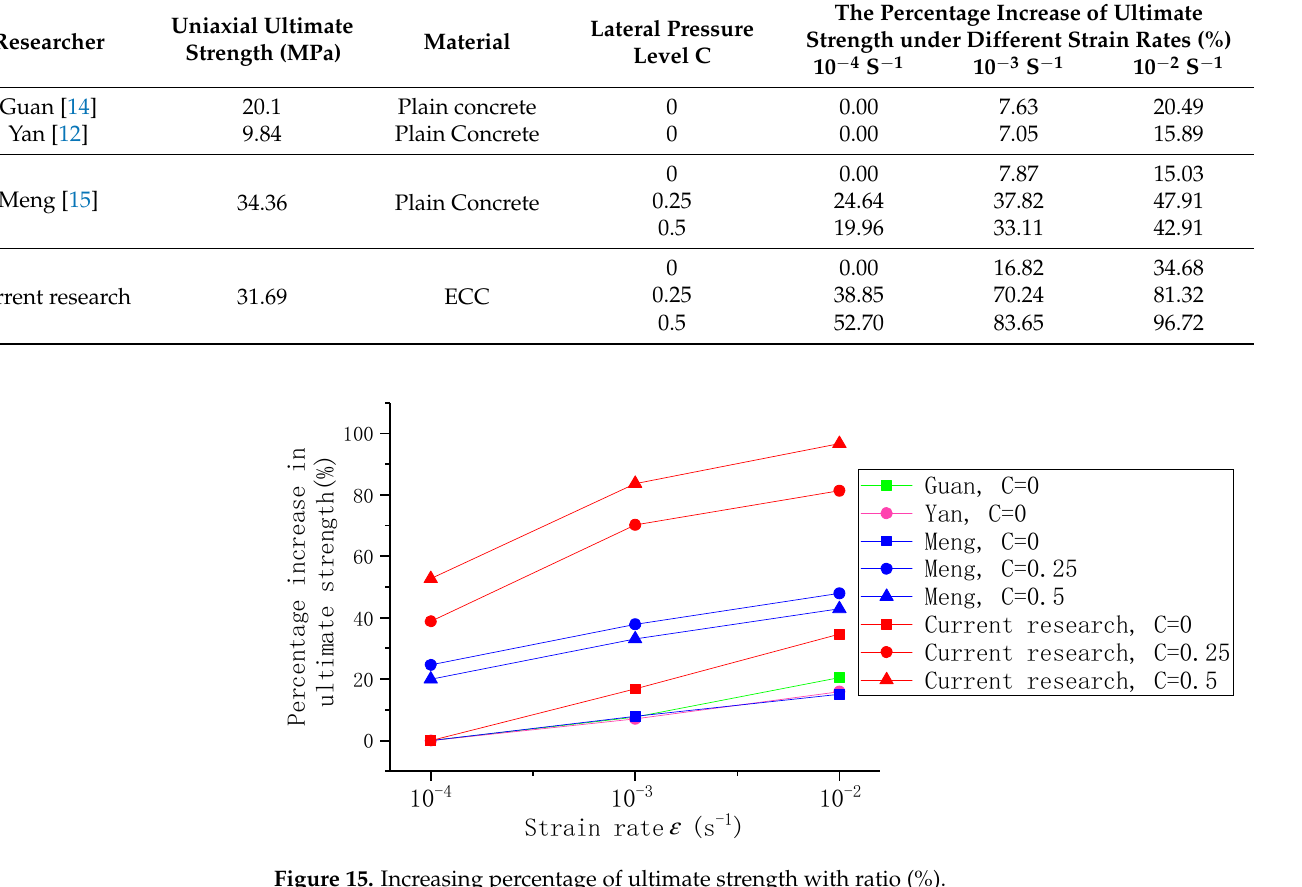
Figure 15. Increasing percentage of ultimate strength with ratio (%).